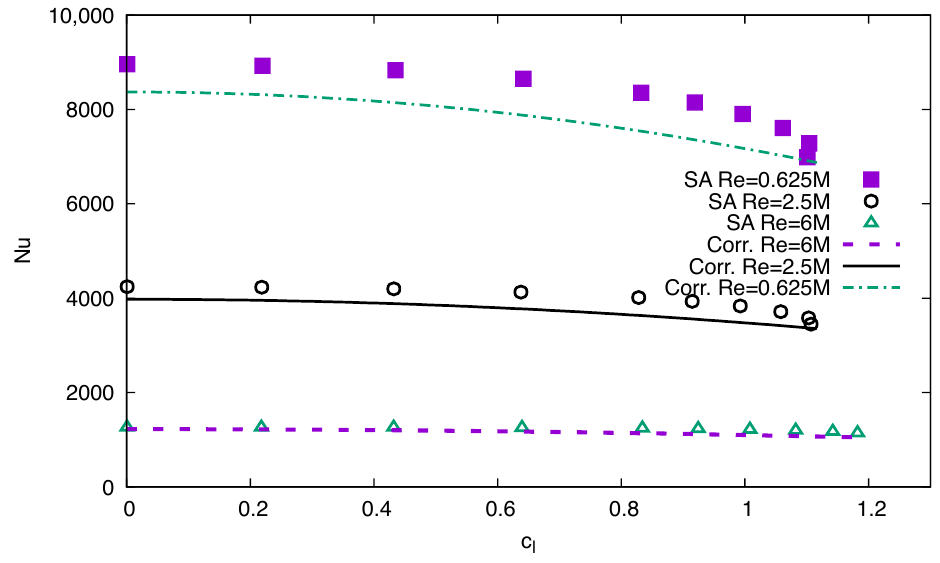
Figure 12. Nu as a function of c l : comparison between CFD results and correlation results for the rough NACA 0012